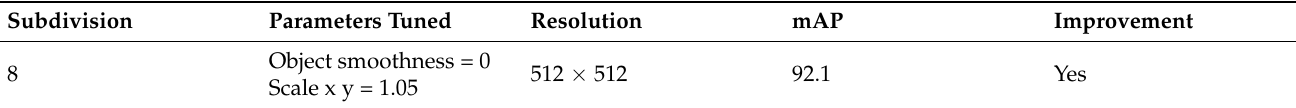
Table 5. Model 3: Scaled-YOLOv4 Optimization Configuration, and Parameter Tuning using GPU Tesla T4.